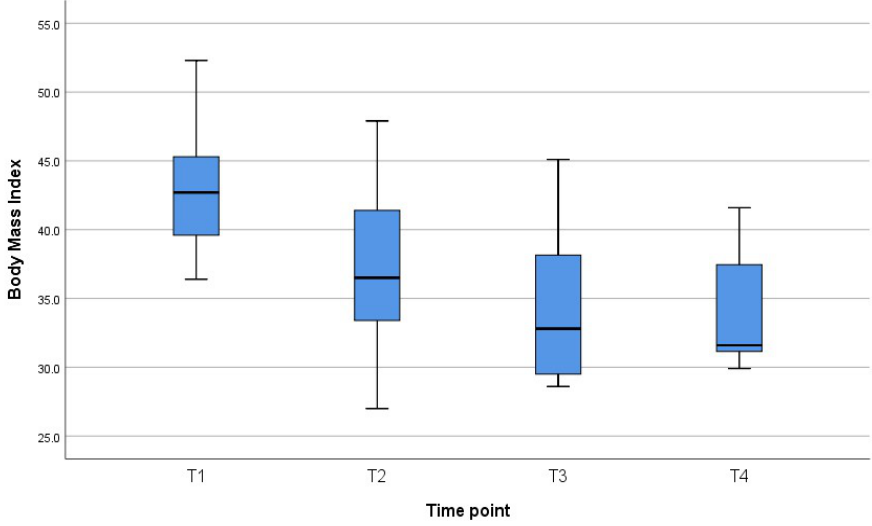
Figure 1. Box plot for BMI for different time points.